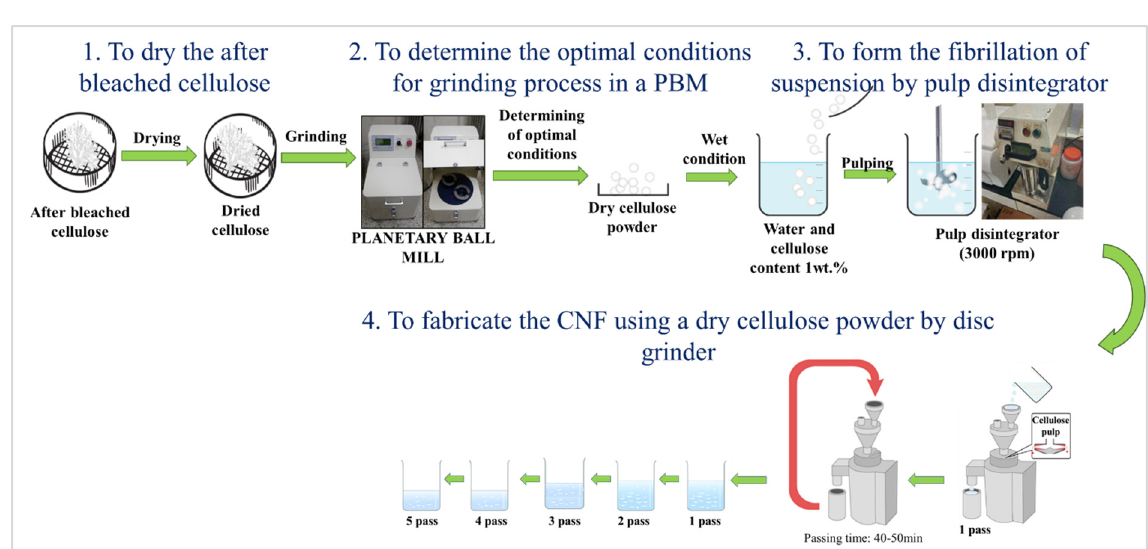
Figure 2. Scheme of method A.